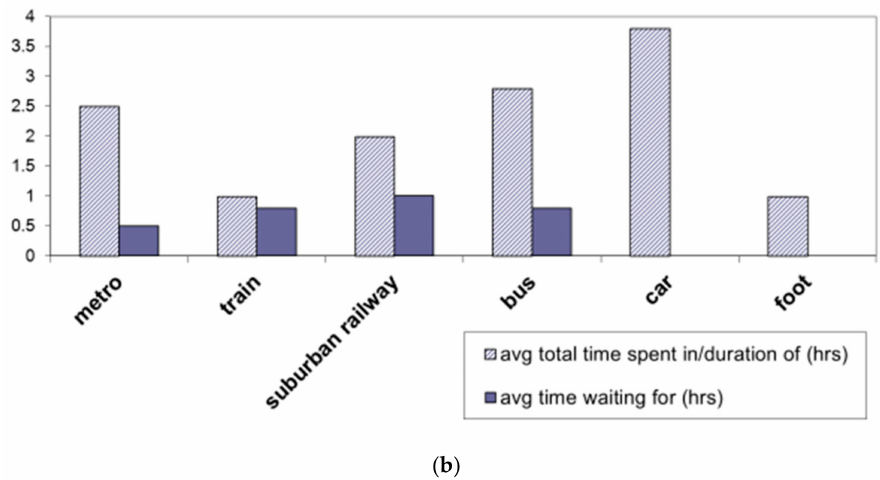
Figure 2. Number of participants per commuting mode ( a ), average total time (h) spent in/during waiting for transit ( b ).